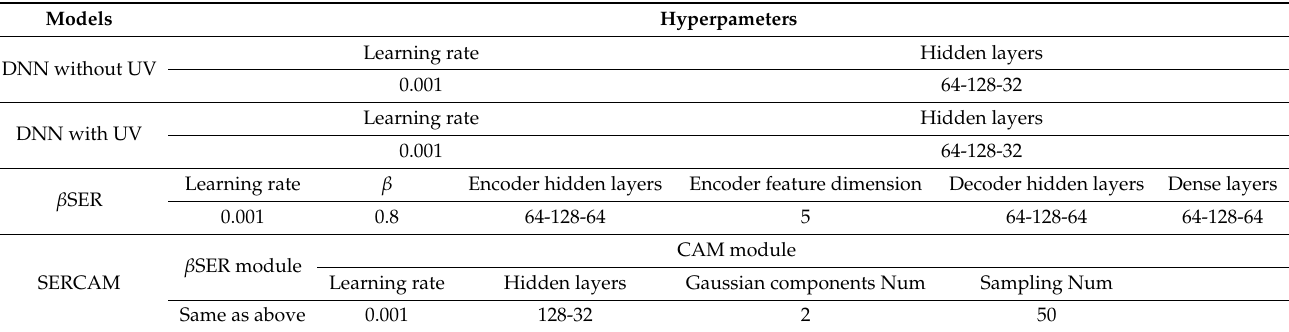
Table 4. Hyperpameters of the methods.